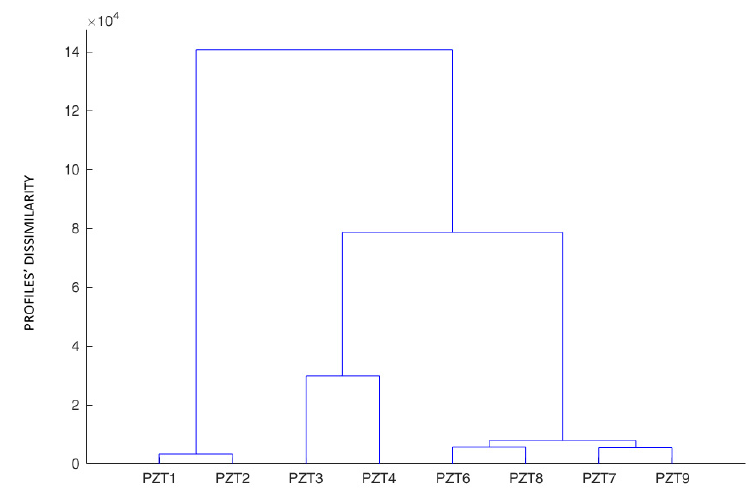
Figure 9. Hierarchical tree for specimen A—baseline stage.